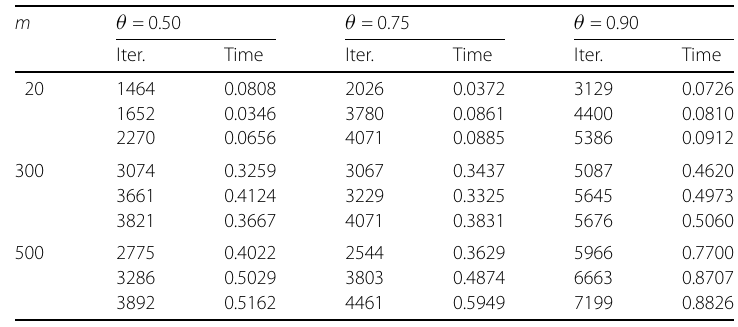
Table 2 Performance of algorithm 3.2 for the number of iterations (Iter.) and the computing time (Time) measured in seconds with m = 20,300,500 m θ = 0.50 θ = 0.75 θ = 0.90 Iter. Time Iter. Time Iter. Time